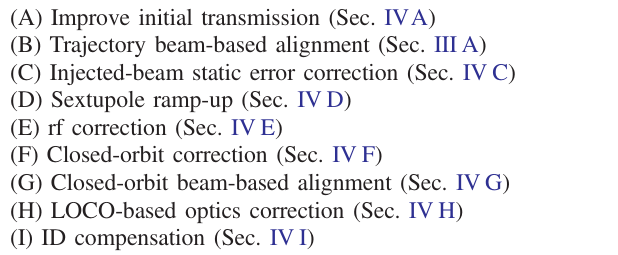
FIG. 10. Beam transmission at various steps of the correction chain. The left-hand plot shows that on day 1 of commissioning without any correction, the beam will almost certainly get lost within the first two arcs. The colored lines in the right-hand plot indicate the beam transmission after performing the correction steps detailed in the